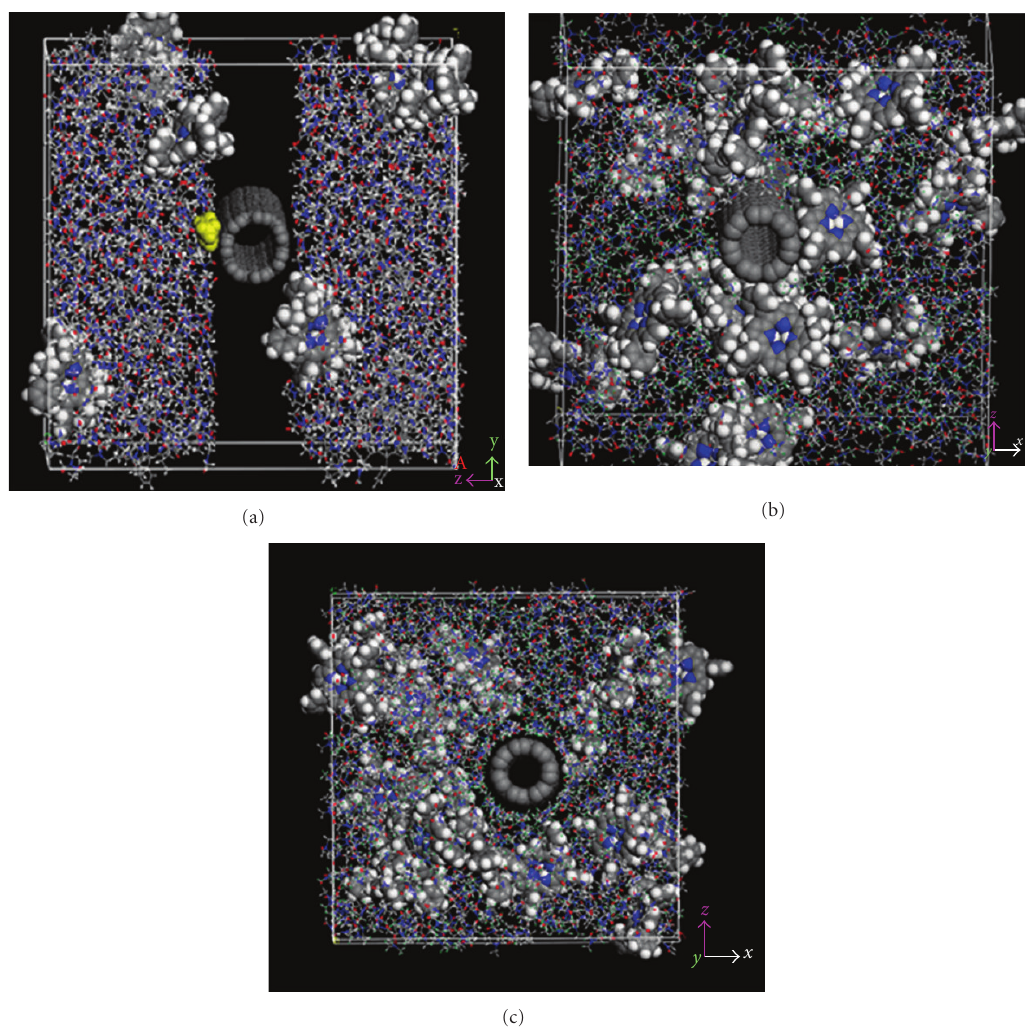
Figure 7: (a) Simulation initial conditions are shown for the HETPP-SWNT-DMF system. While there are 20HETPP molecules, only 4HETPP molecules, a single DMF (yellow) molecule, and the SWNT are actually rendered using e ff ective Van der Waals diameters. The box is in fact repeated in all directions periodically, to simulate a bulk solvent, and an infinitely long SWNT. (b) The DETPP-SWNT-DMF solvent system. The pronounced tendencies of DETPP to aggregate on, and close to the SWNT, are evident. (c) The TPP-CNT-DMF solvent system. There is no tendency for TPP to aggregate on or close to the CNT.